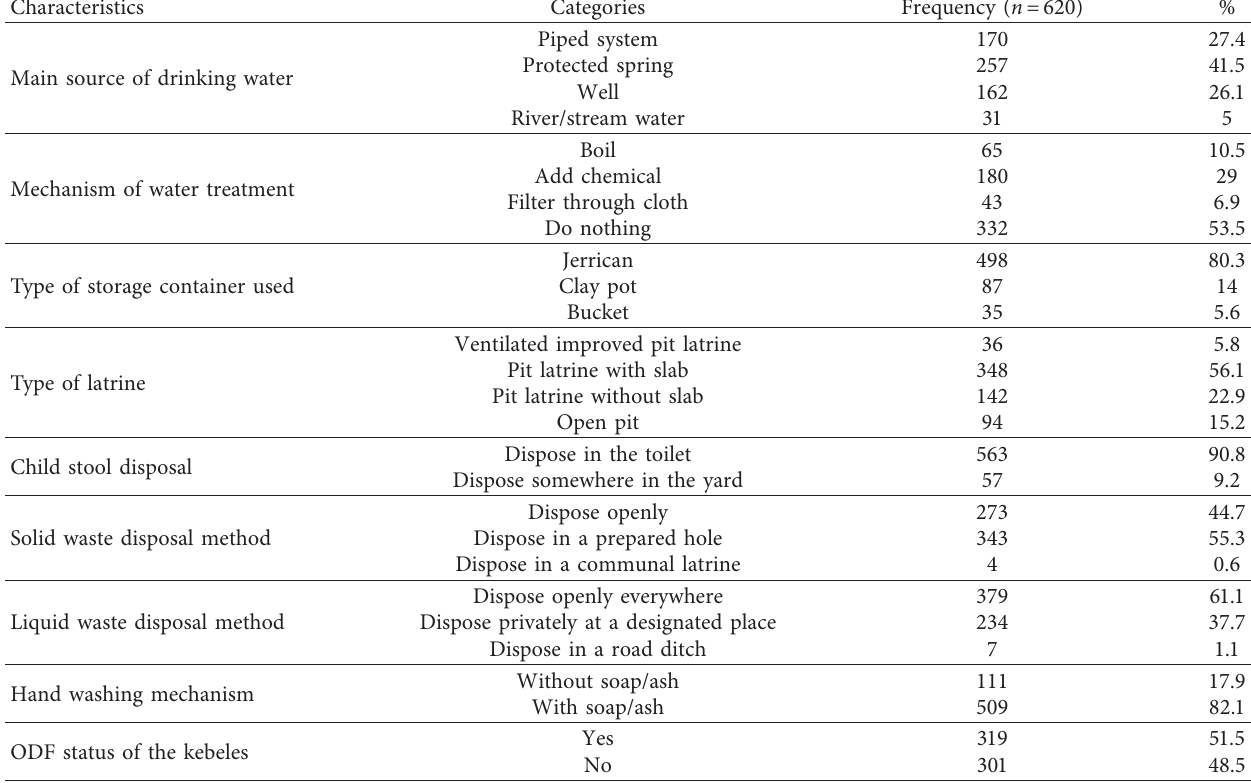
Table 2: Environmental characteristics of participants in Horo Guduru Wollega Zone, Oromia Region, Western Ethiopia, from February 15 to March 10, 2018 ( n � 620).